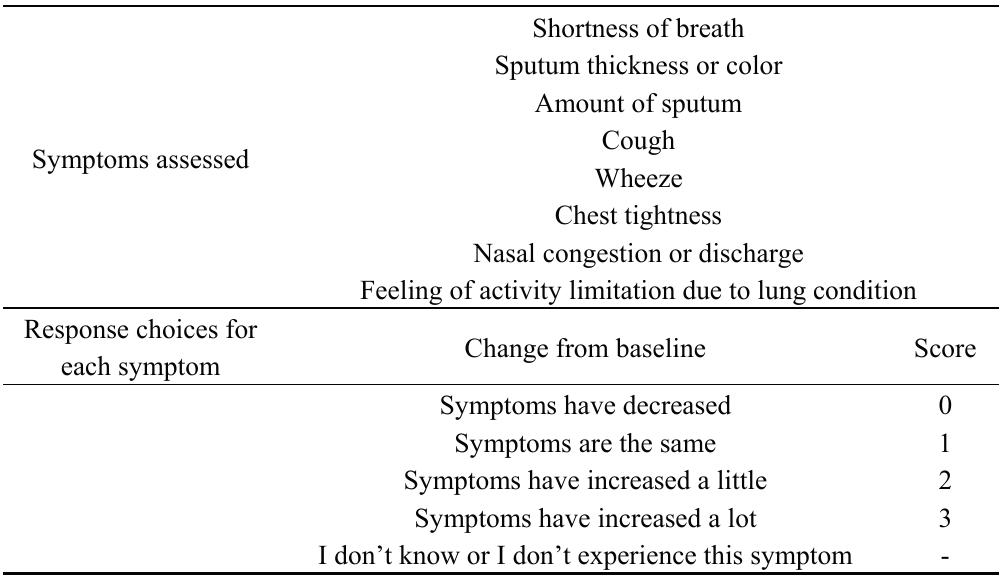
Table 2. Respiratory symptom